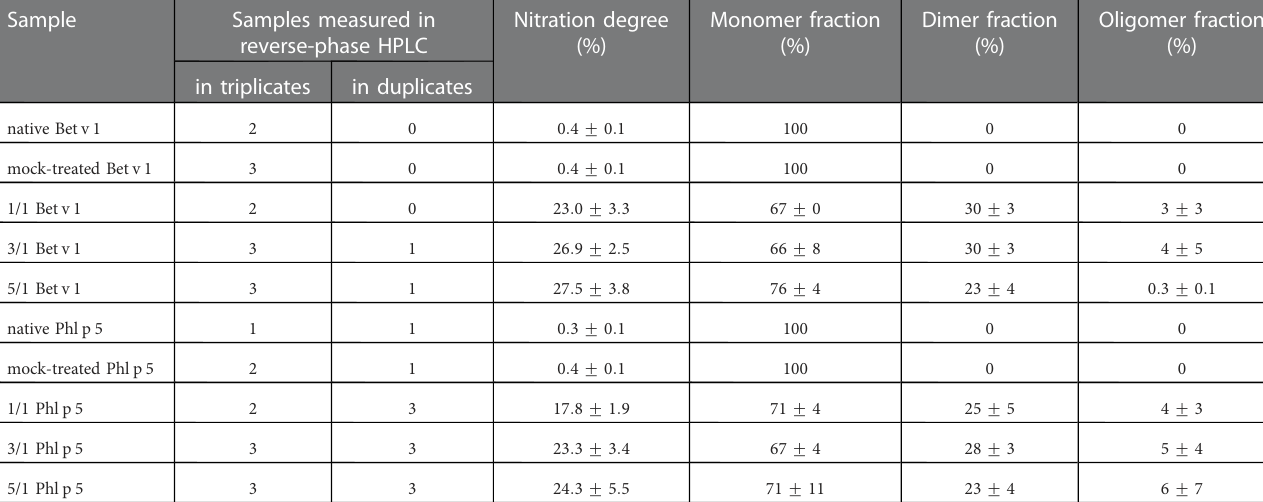
TABLE 1 Nitration degree and relative fractions of monomers, dimers, and oligomers of native, mock-treated, and modi fi ed Betv1 and Phlp5 (arithmetic mean values and standard deviations). The allergens were modi fi ed with different molar ratios of ONOO – over tyrosine (1/1, 3/1, 5/1). Nitration degrees were determined by reversed-phase HPLC for two to six independent prepared samples measured in triplicates or duplicates, monomer/dimer/oligomer fractions were determined by SDS-PAGE for two to three independent prepared samples.